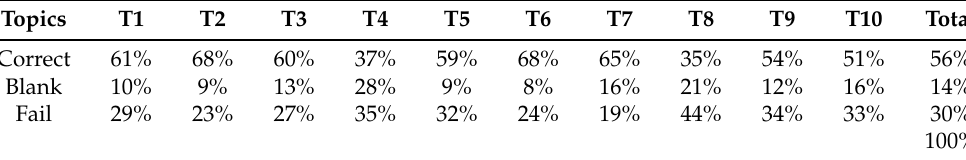
Table 8. Summary of results year 2020–2021.